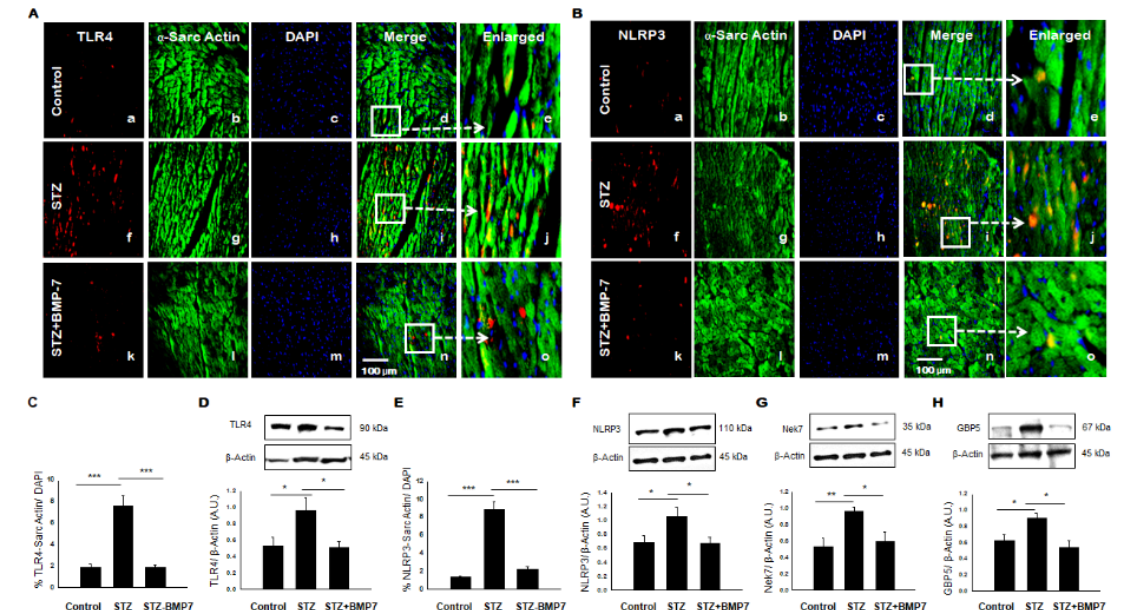
Figure 2. BMP-7 attenuates the expression of TLR4, NLRP3, and NLRP3 activators (Nek7 and GBP5) in the diabetic heart. ( A , B ) Representative photomicrographs of heart sections stained in the control group (a–e), STZ group (f–j) and STZ-BMP7 group (k–o) with sarcomeric- α actin (green, stained cardiac myocyte) (b, g, l) and pyroptotic markers TLR4 ( A ) and NLRP3 ( B ) in red (a, f, k) with nuclei stained (c, h, m) by DAPI in blue, merged (d, i, n) and enlarged (e, j, o) image. ( C , E ) Quantitative analysis-derived histograms of pryoptotic TLR4 ( C ) and NLRP3 ( E ) +ve cardiomyocytes (colocalization of both red and blue DAPI in green cardiomyocyte) were quantified over total DAPI in heart sections of mice. ( D , F , G , H ) Representative Western blots and densitometric analysis of inflammasome TLR4 ( D ), NLRP3 ( F ), Nek7 ( G ), and GBP5 ( H ) markers are shown. Quantities are presented as an arbitrary unit (A.U). Statistical analysis was performed using One-Way ANOVA, which was followed by the Tukey test. Error bars = mean ± S.E.M. * p < 0.05, ** p < 0.01, *** p < 0.001; Scale bar = 100 µm; n = 16/group.